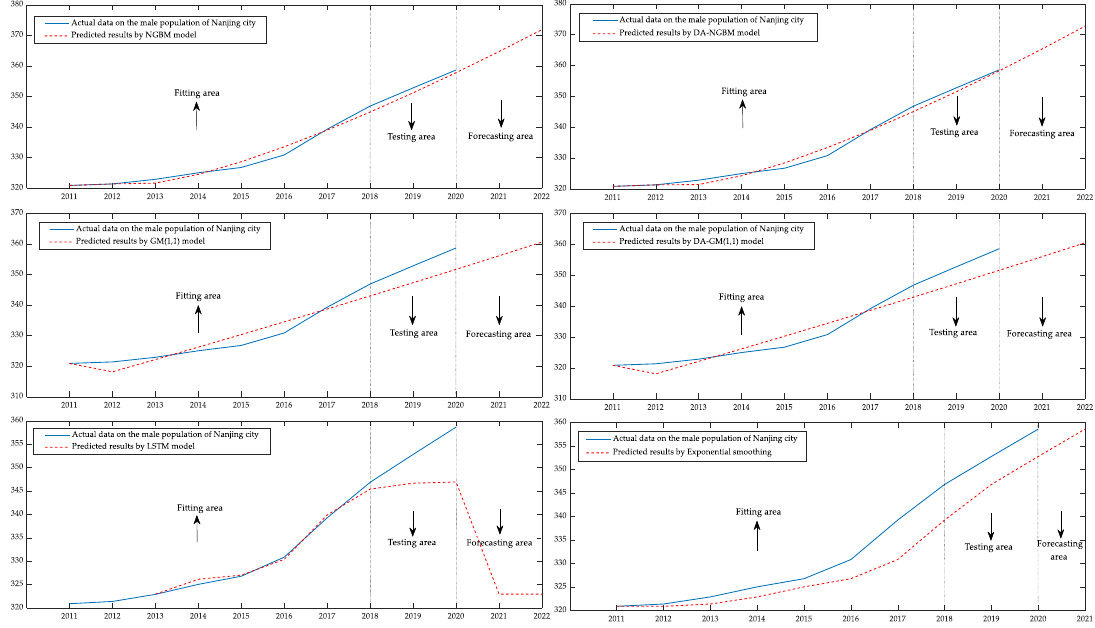
Figure 5. Comparison of the fitting and prediction curves of the male population of Nanjing city from 2011 to 2022.